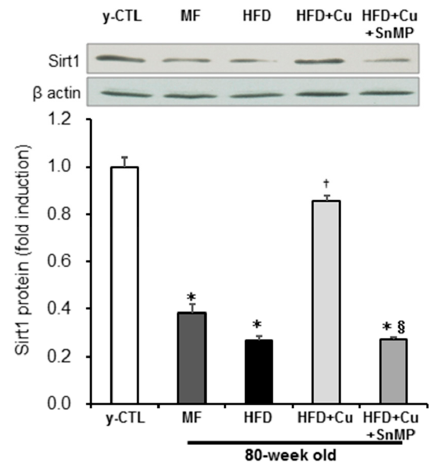
Figure 4. Effect of curcumin on Sirt1 expression in mice. MF (standard feed), High-fat diet